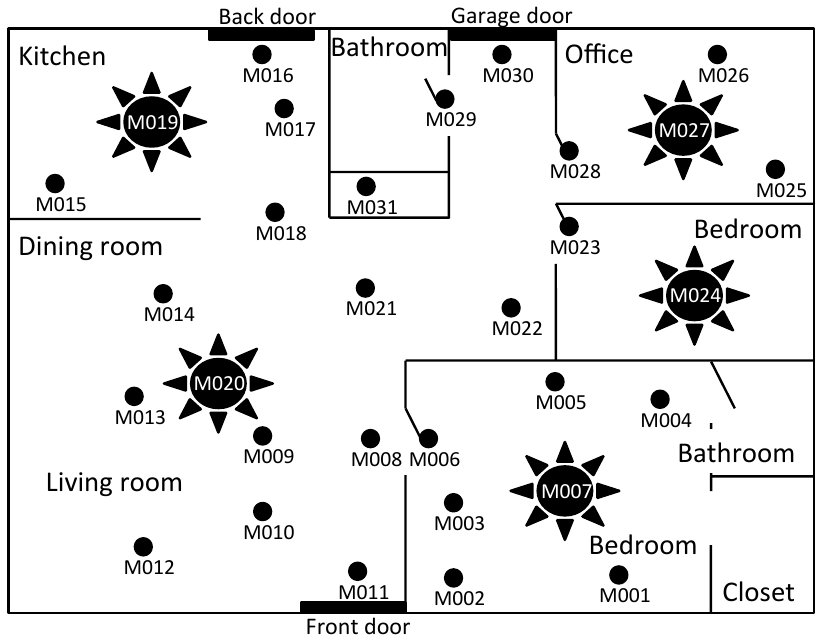
Figure 5. The floor and sensor deployment plan in a smart home